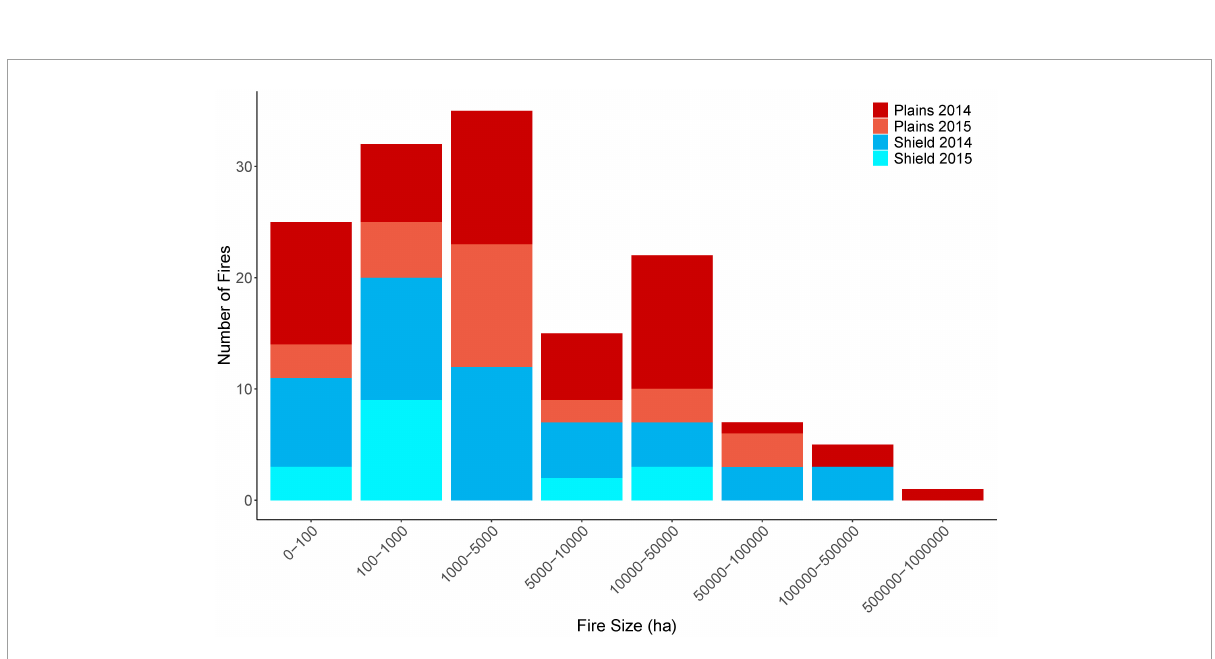
FIGURE3 Frequency distribution of fire size (ha) for the fires within the study area, symbolized to show contributions by ecoregion and year.